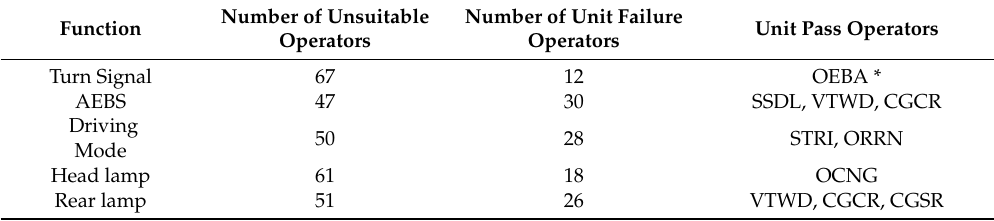
Table 2. Mutation operator selection for fault injection.